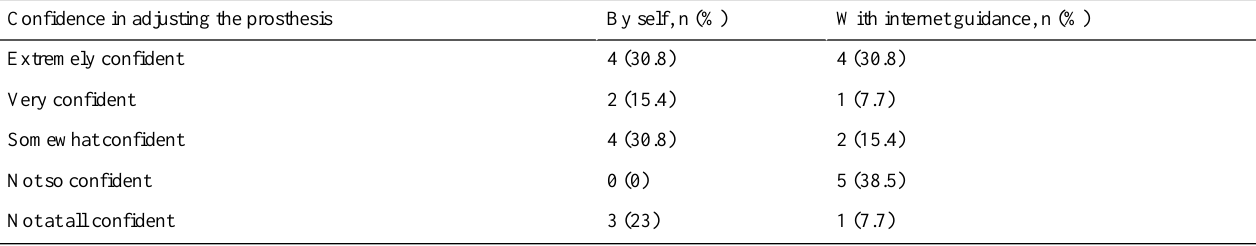
Table 6. The confidence of lower limb amputees adjusting their own prosthesis (n=13).